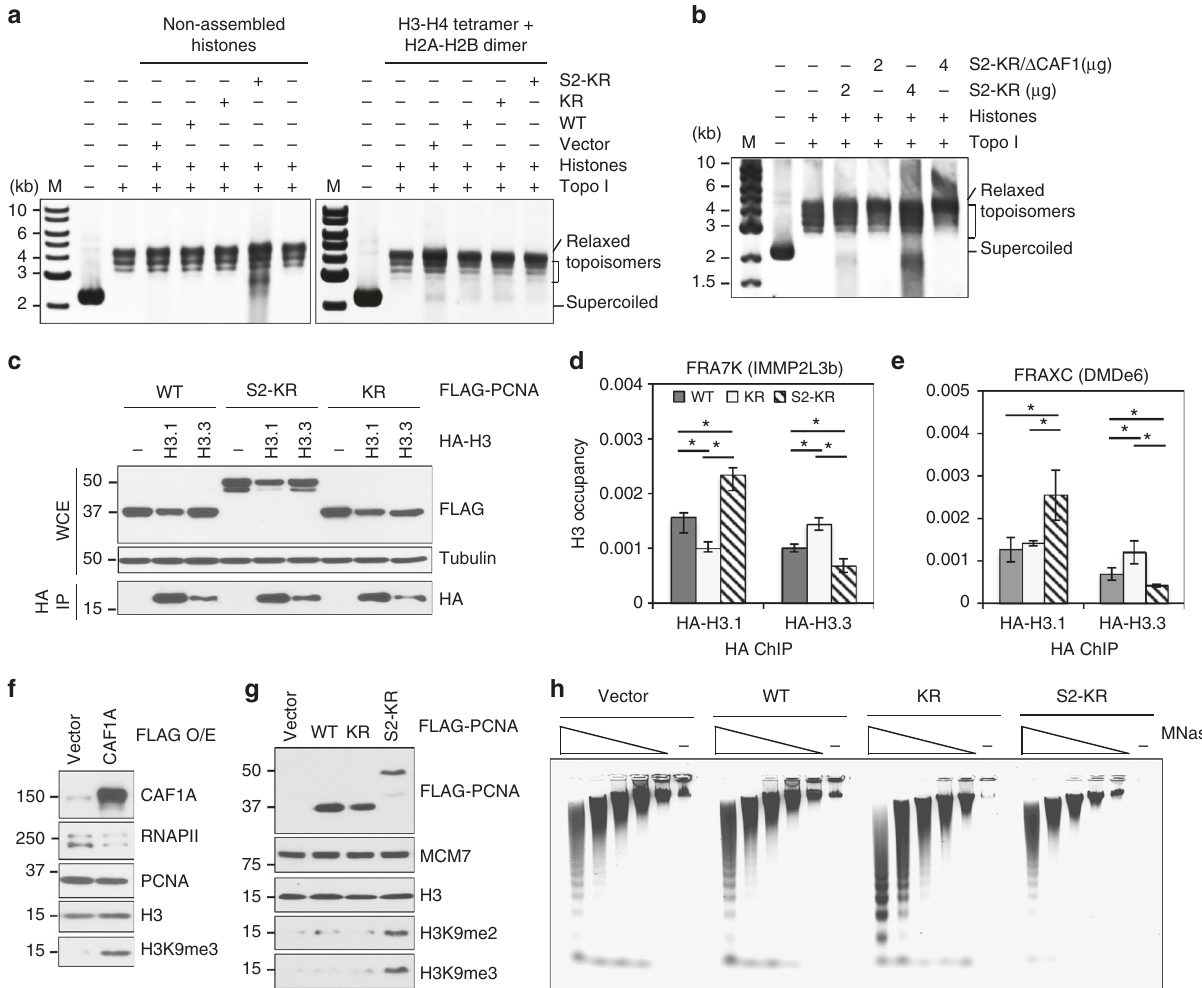
Fig. 5 SUMO2-PCNA enhances deposition of CAF1-dependent histone H3.1. a DNA supercoiling assays to detect nucleosome assembly. Reactions were initiated by mixing cytoplasmic extracts (6 µ g each) from HEK293T cells transfected with a control vector, or WT, K164R (KR), or SUMO2-KR (S2-KR) PCNA with puri fi ed, non-assembled histones (left panel) or pre-assembled H3-H4 tetramer and H2A-H2B dimer (right panel) in a reaction containing relaxed circular DNA plasmids (200 ng, linear length: 3.0 kb) pre-treated with topoisomerase I (Topo I). After deproteination to stop the reaction, DNA molecules were precipitated and analyzed by agarose gel electrophoresis. Supercoiled DNA, relaxed DNA, and topoisomers are indicated. b DNA supercoiling assays to detect nucleosome assembly using the indicated amounts of control or CAF1-depleted cytoplasmic extracts from S2-KR- overexpressing HEK293T cells. c (top) Western blot analysis of expression of the indicated FLAG-PCNA complexes in whole cell extracts (WCE) of HEK293T cells co-transfected with the indicated HA-tagged histone H3 or vector alone. Tubulin was used as a loading control. (bottom) Western blot analysis of HA-H3 immunopuri fi ed from the indicated cells with an HA antibody. d , e ChIP analysis of the samples from ( c ) for HA-H3.1 and HA-3.3 occupancy at the FRA7K ( d ) and FRAXC ( e ) gene regions. Each average value ± standard deviation was calculated from triplicate qPCR reactions per one representative experiment. p values were calculated by t-test analysis for statistically signi fi cant differences. p values equal to or less than 0.05 are indicated with an asterisk (*).The result was reproduced in three independent assays. f Western blot analysis of CAF1, RNAPII, histone H3, and H3 tri- methyl lysine 9 (H3K9me3) in WCE of HEK293T cells with or without FLAG-CAF1 overexpression. g Western blot analysis of FLAG-PCNA,